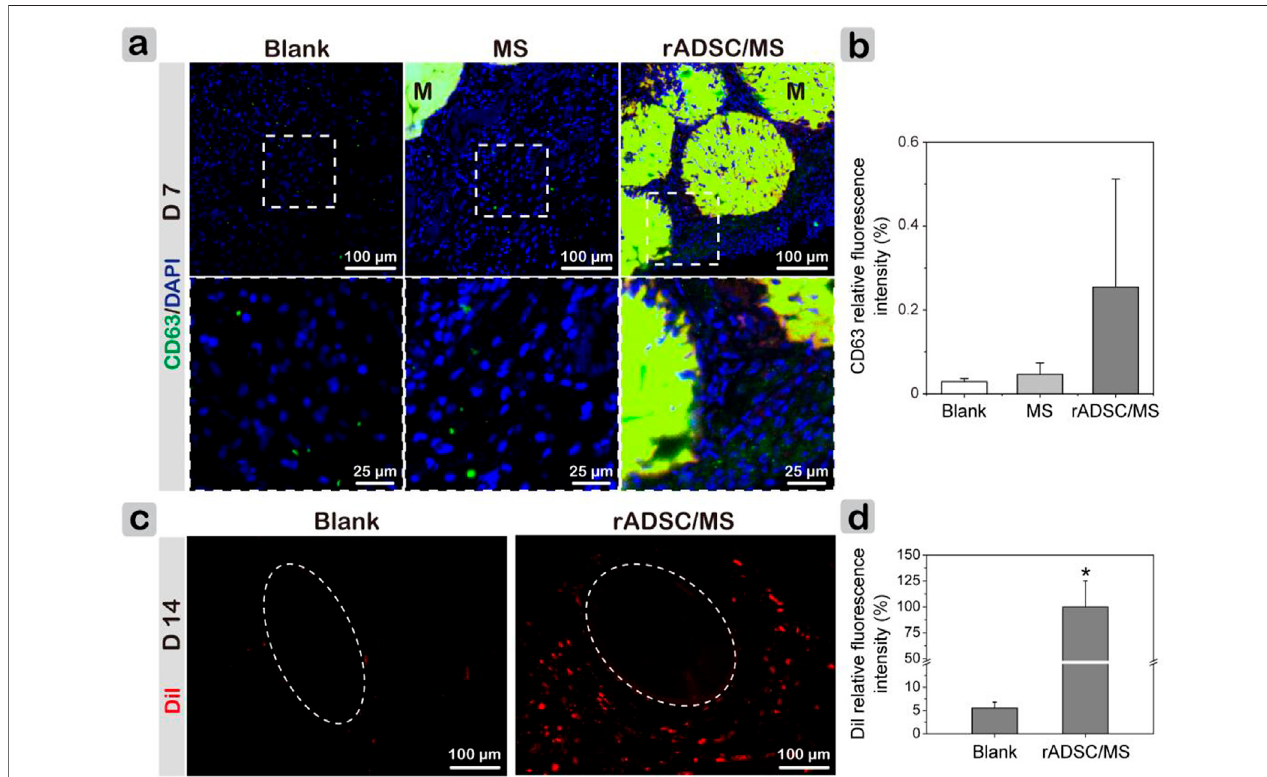
FIGURE 7 | Investigating paracrine performance of encapsulated rADSCs during wound healing. (A) CD63 staining results showing presence of exosomes in regenerated tissues on day 7. Local magni fi ed images were also shown. CD68 antibody was conjugated with Alexa Fluor 647 (650/668 nm). “ M ” represents gelatin microspheres. (B) CD63 fl uorescence intensity of three groups on day 7. (C) CLSM images of wound sections without any staining on day 14. Dotted circles represent hairbulbsinsubdermallayer, andrADSCsingelatinmicrospheres werelabeled withCM-Dil (Dil). (D) CorrespondingDilrelative fl uorescenceintensityforblankand rADSC/MS groups. Intensity was calculated using ImageJ. Data = mean ± SD, n = 3, * p < 0.05 when compared with blank